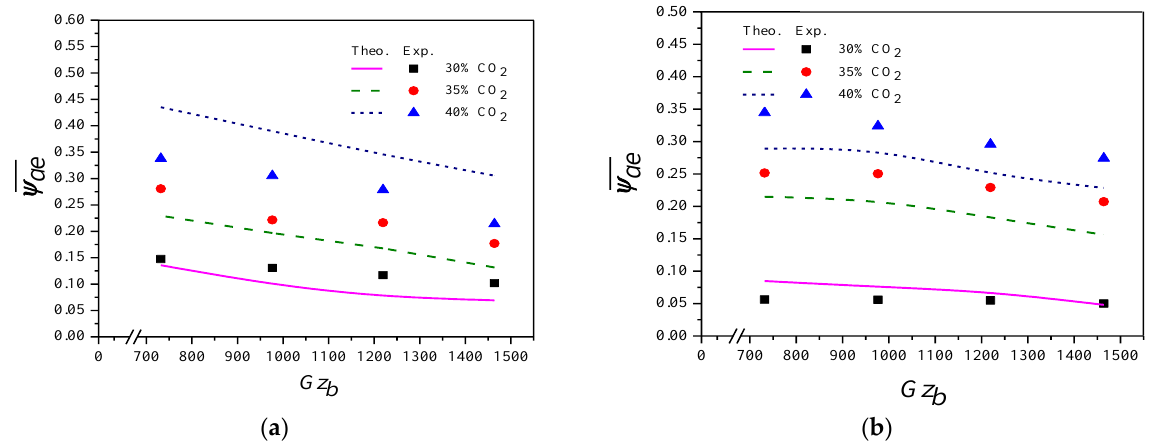
Figure 7. Effects of 𝐺𝑧 𝑏 and inlet CO 2 concentration on outlet CO 2 concentration ( 𝐺𝑧 𝑎 = 710). ( a ) Concurrent-flow operations; ( b ) Countercurrent-flow operations.